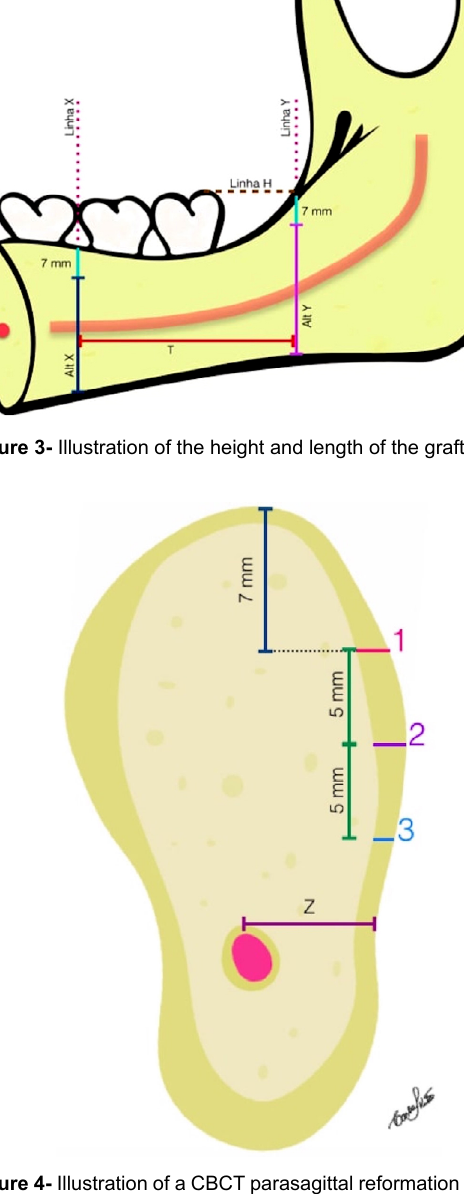
Figure 4- Illustration of a CBCT parasagittal reformation showing the positions of points 1, 2, 3 and of Line